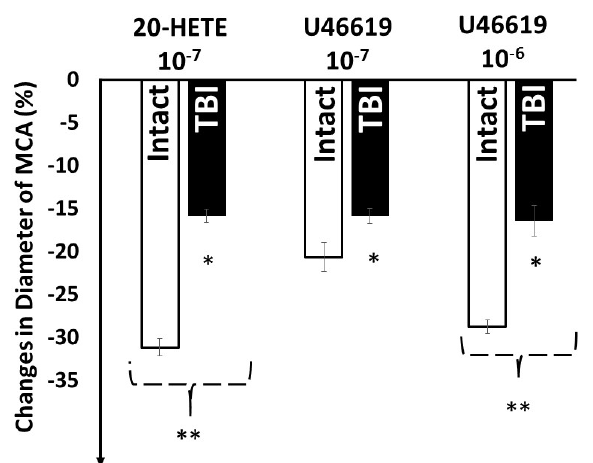
Figure 5. Changes in diameter of isolated middle cerebral arteries (MCAs) in response to 20- hydroxyeicosatetraenoic acid (20-HETE, 10 − 7 mol/L) metabolite of cytochrome P450 4A enzyme (CYP450 4A) and U46619 (10 − 7 mol/L and 10 − 6 mol/L a stable agonist of TP receptors, intact and after traumatic brain injury (TBI). Data are mean ± SEM. Asterisks indicate significant differences (* p < 0.05 from zero, Intact 20-HETE 10 − 7 ** p < 0.05 vs. TBI 20-HETE 10 − 7 and Intact U46619 10 − 7 , Intact U46619 10 − 6 ** p < 0.05 TBI U46619 10 − 6 Σ n= 24, n = 6 in each